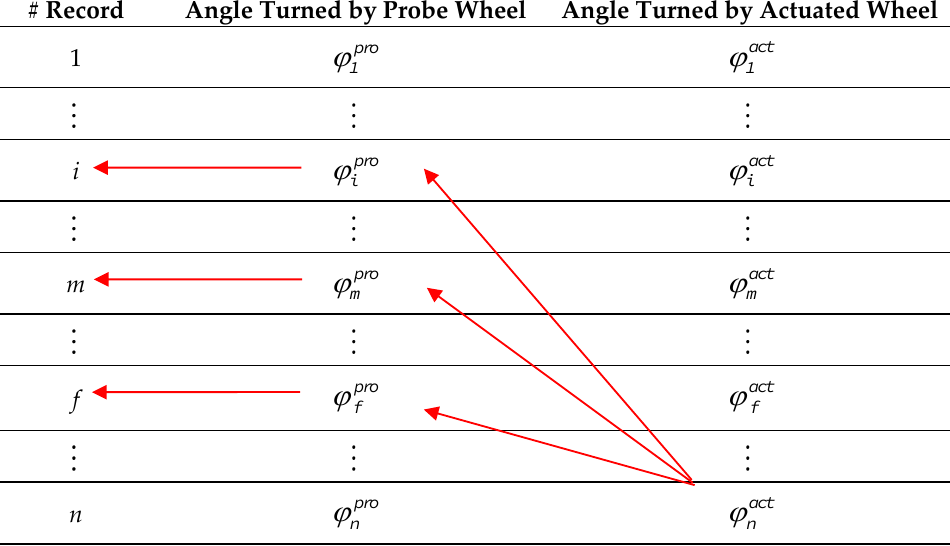
Table 4. Time “ n ∆ t ” database.